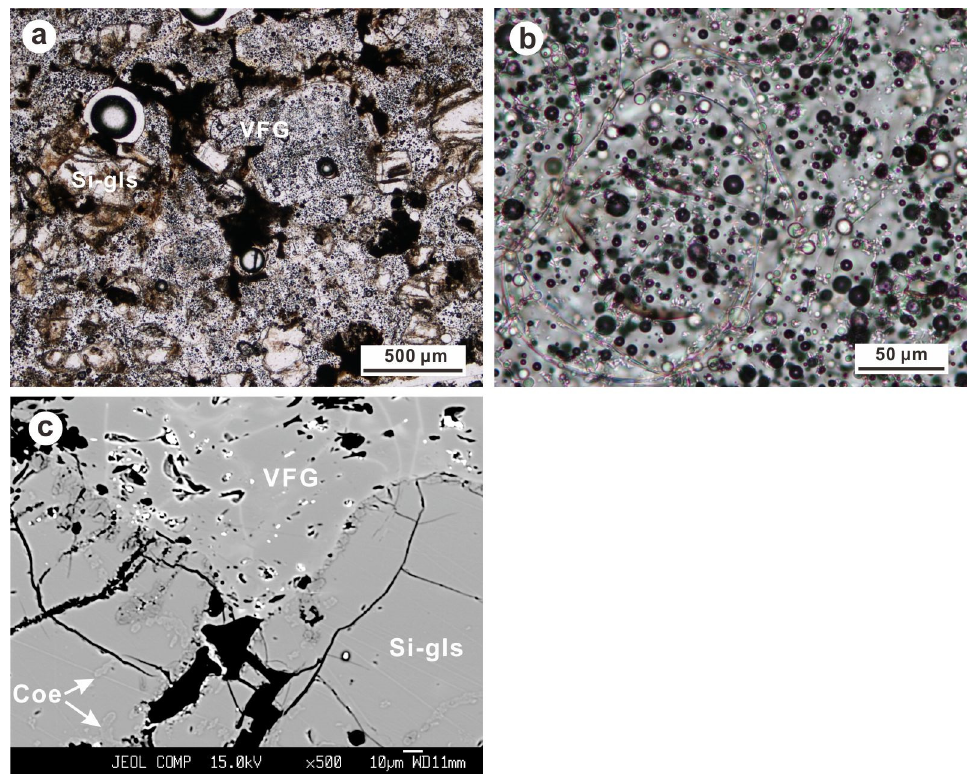
Figure 6. Strongly shocked feldspars. ( a , b ) VFG contains abundant vesicles (PPL). ( c ) BSE image shows that VFG coexists with coesite-bearing silica glass and the boundary between them is clear. Si-gls—Silica glass, Coe—Coesite.